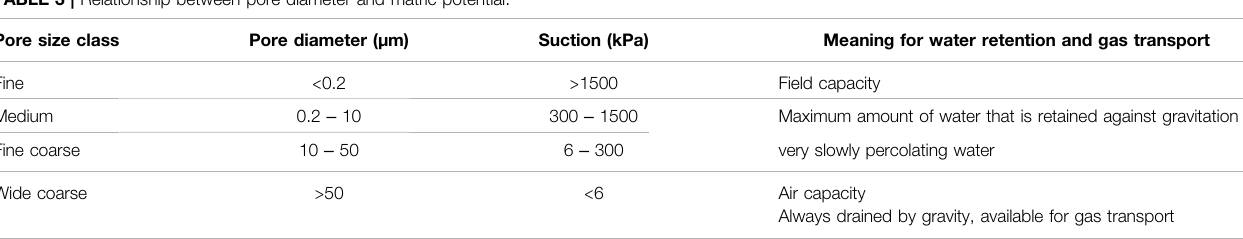
TABLE 3 | Relationship between pore diameter and matric